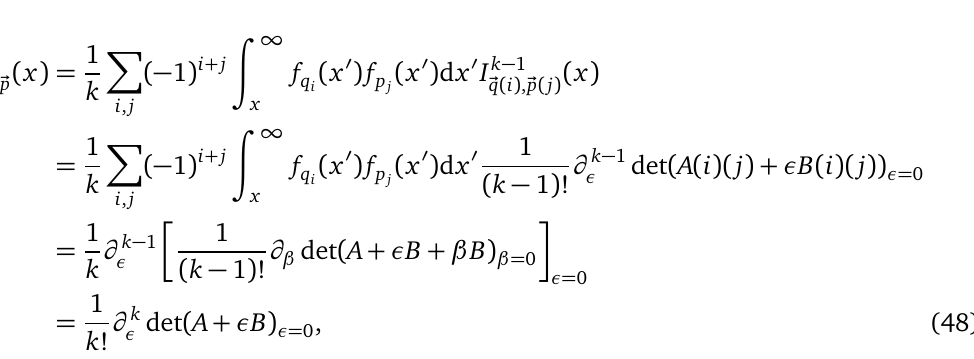
Figure 8: Position space density for the ground state at g system in the harmonic potential, for different basis sizes compared to the matrix product states method. The density profile localized in the center is the minority density and the other one is the majority